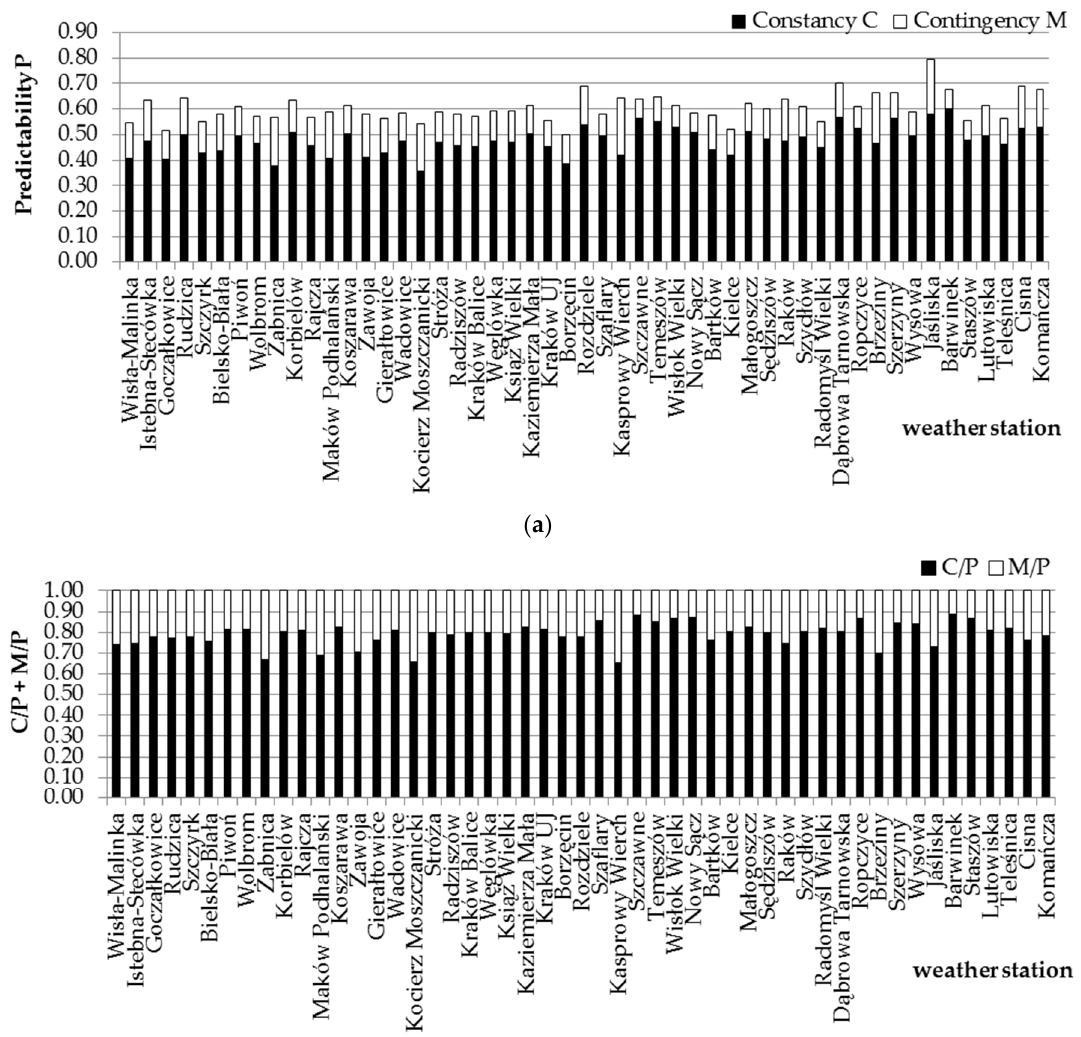
Figure 7. Colwell indices values: ( a ) C , M , and P parameters; and ( b ) M / P and C / P ratios.